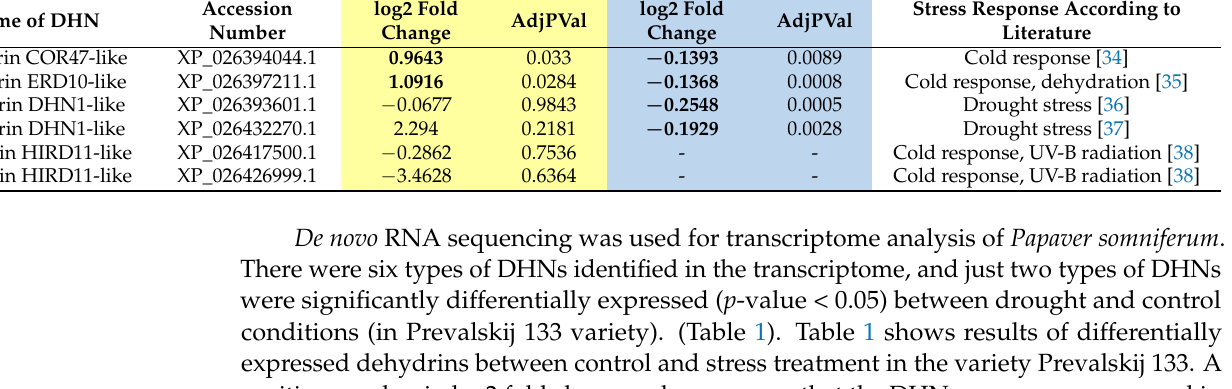
Table 1. Overview of different types of DHNs found in the transcriptome (light yellow) and proteome (light blue) of the Prevalskij 133 variety (variety sensitive to drought). A negative number in the log2 fold change column means that the DHN was more expressed in the stress treatment compared to the control. Significant log2 fold changes are in bold ( p -value < 0.05 adjusted to false discovery rate). The names and accession number of DHNs were obtained using BLASTp and the NCBI Database. Name of